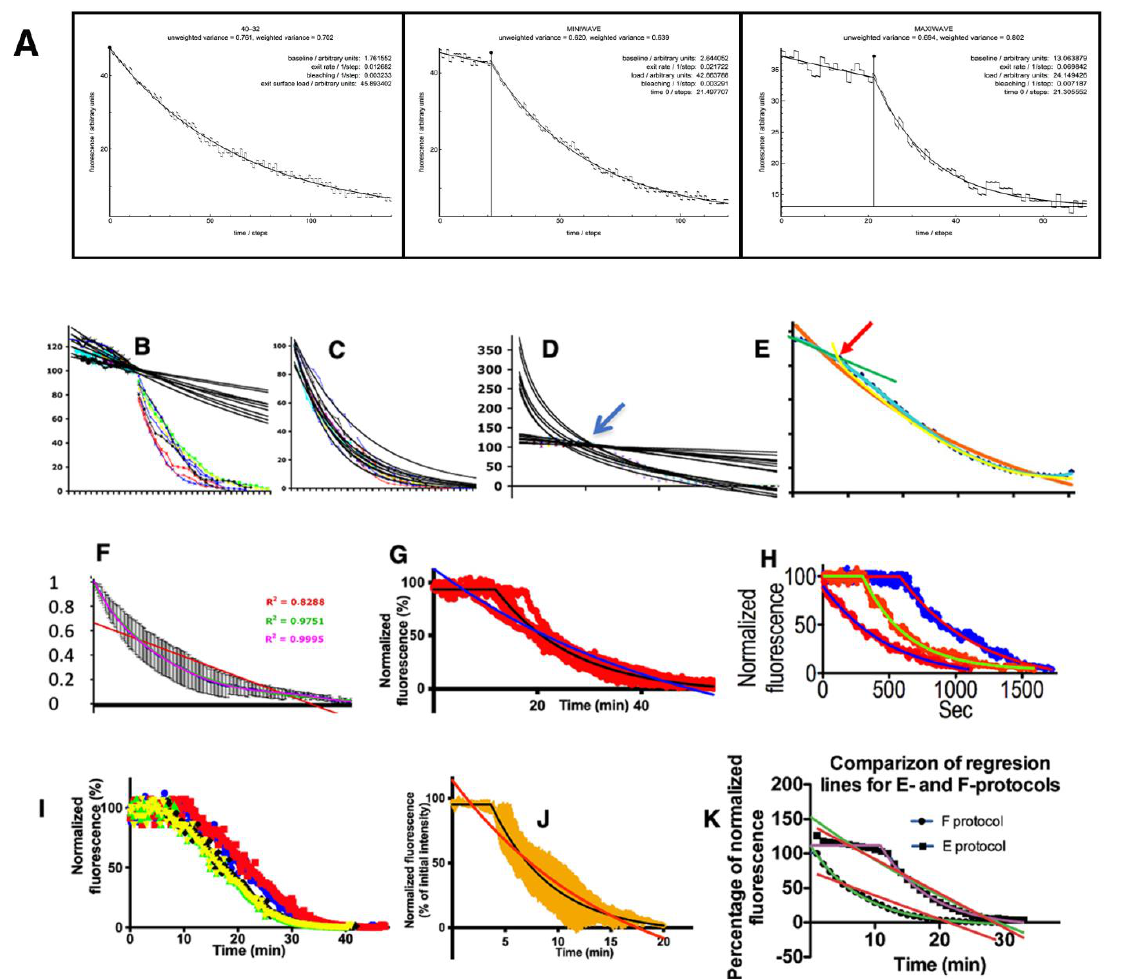
Figure 3. Analysis of regression lines describing the exit of cargoes from the Golgi zone. ( A ) Examples of regression lines. ( B ) The first part of this complex regression lines fits better to the linear decline. ( C ) The exponential-decay regression lines for the second parts of the curves presented. The second part of the regression line fit better to the exponential decay-like curve. ( D ) Overlapping of the first and the second parts of the regression lines. The intersection (arrow) between the linear decay (the initial part of curves and exponential decay (the second part of the curve) indicates the point where the slope of the curve changes (the point of bending; arrow). ( E ) The regression line describing the piFRAP synchronization protocol and containing the initial part similar to the linear decay followed by the exponential decay. Orange line represents the exponential decay with maximal fitness for the whole regression line. Light blue line demonstrates polynomial line. The first part of the line is approximated with the liner decay (green line), whereas the second part is correlated with its own exponential decay (yellow line). ( F ) Averaging of the regression lines describing the iFRAP protocol. Six single regression lines were placed in one graph. ( G ) Variability of the experimental conditions and the ability of an operator to start acquisition of images led to the heterogeneity of regression lines with the horizontal initial parts of different lengths. ( H ) Within the same experimental conditions but with different cargoes, the initial horizontal part could have different lengths. ( I ) The regression lines were aligned using the point of bending as the reference point. ( J ) The averaging was performed after the alignment of regression lines. ( K ) Different theoretical curves were estimated from individual experimental regression lines (see Tables 3–5). The magenta curve indicates the combination of the horizontal line and exponential decline. Red lines indicate the linear decline. Green lines indicate the exponential